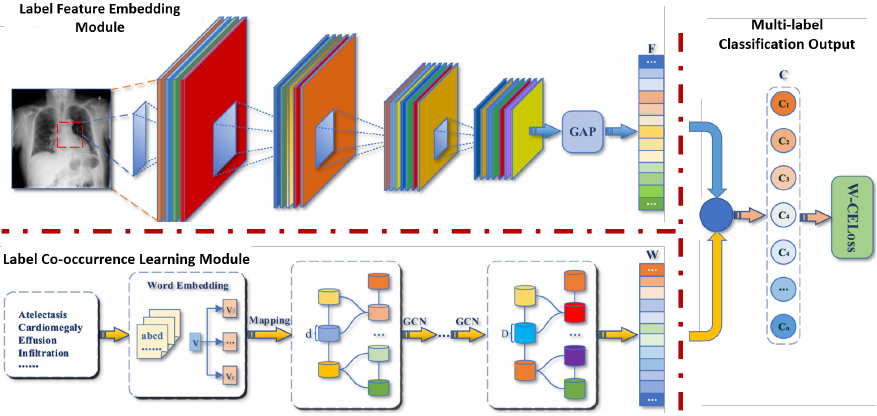
Figure 7. A GCN-based label co-occurrence learning framework to explore potential abnormalities with the guidance of semantic information, including the pathology co-occurrence and interdepen- dency. Image adapted from